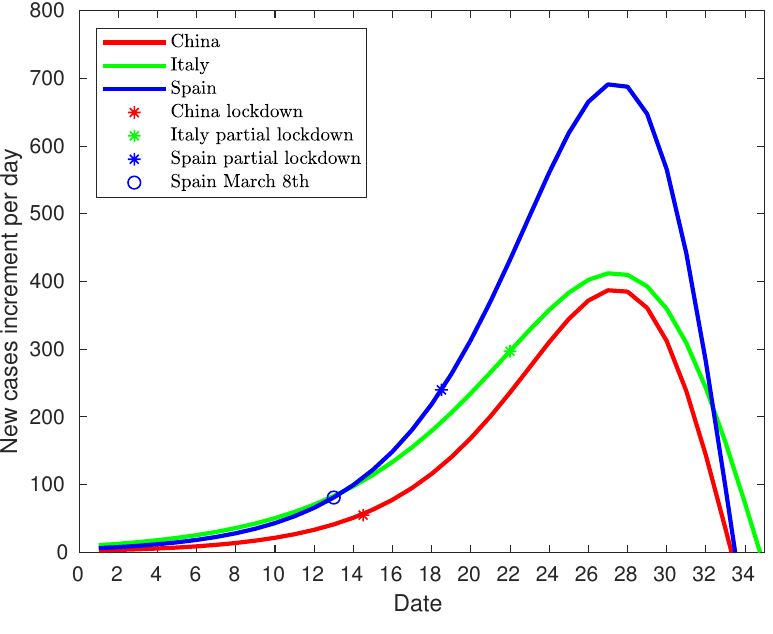
Figure 18. Comparison of centered rate of new